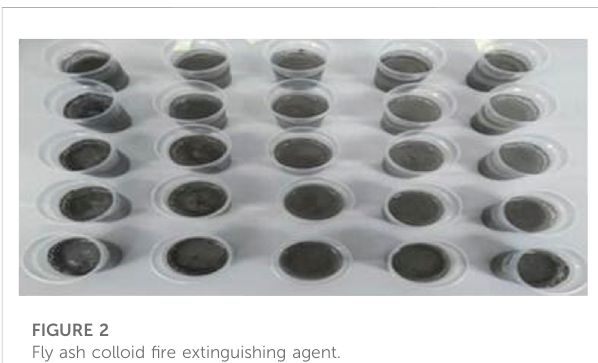
FIGURE 2 Fly ash colloid fi re extinguishing